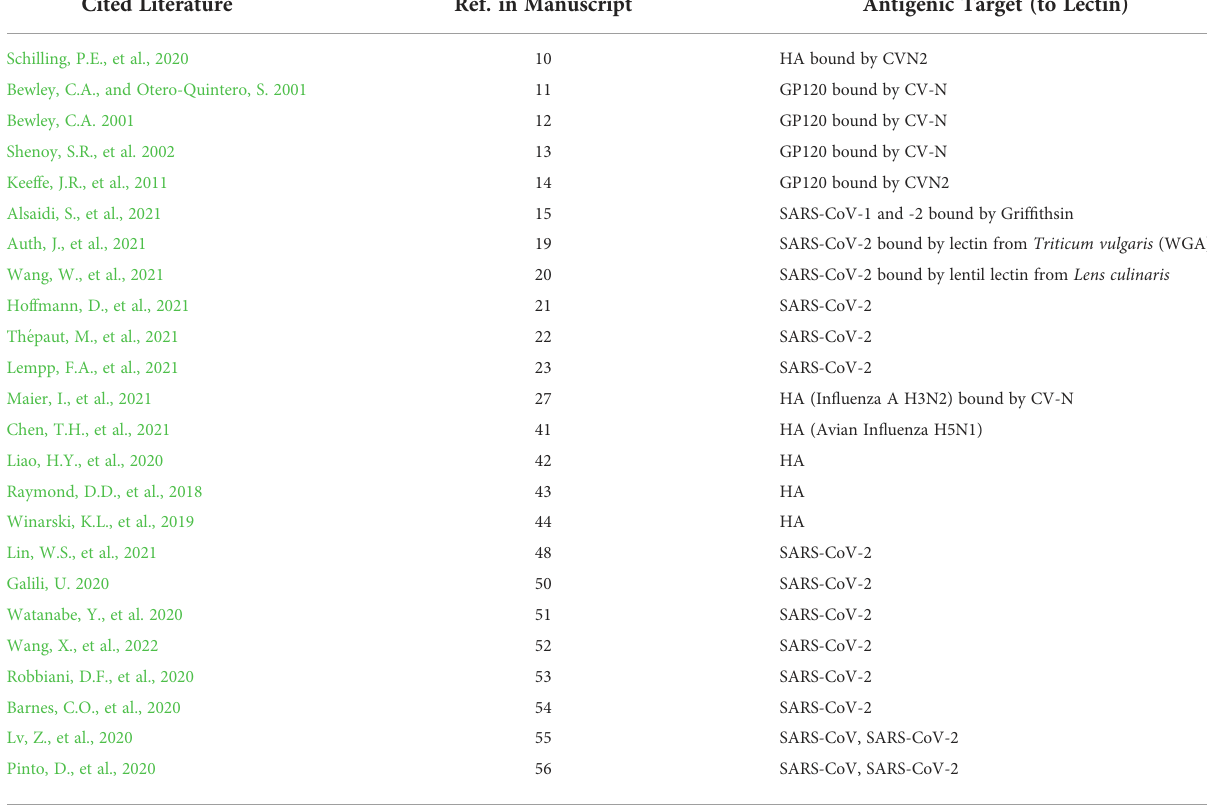
TABLE 1 Literature on viral spike glycoproteins GP120, HA, and SARS-CoV (2)